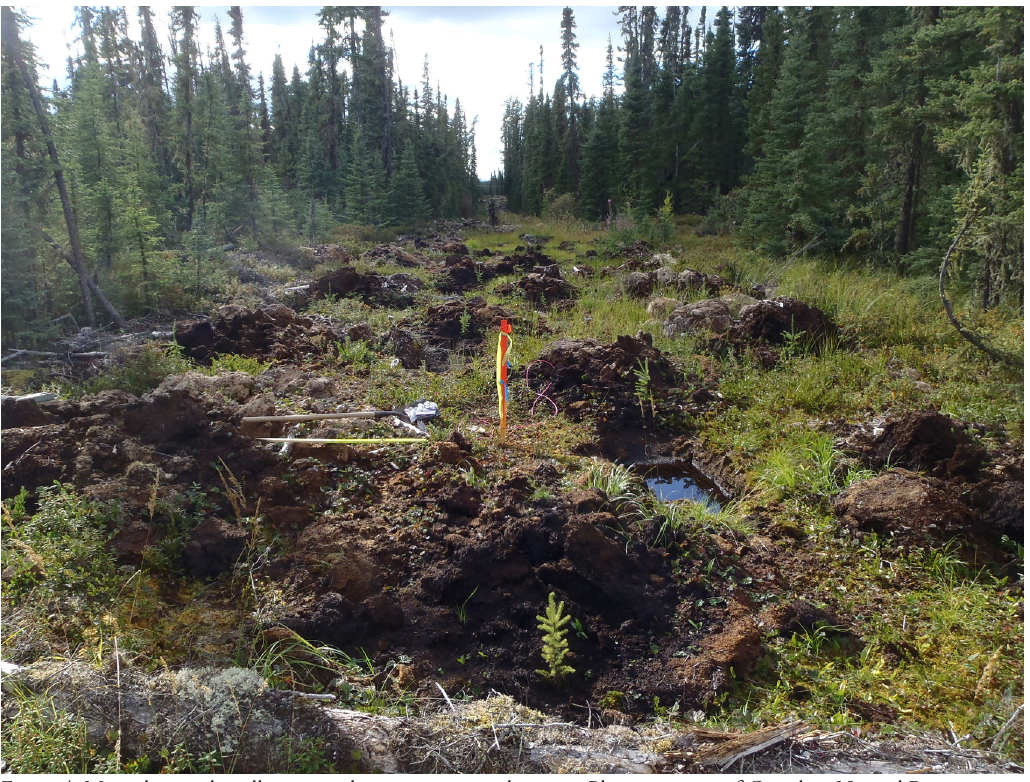
Figure 4. Mounding and seedling transplanting treatment location. Photo courtesy of Canadian Natural Resources Ltd. Primrose and Wolf Lake